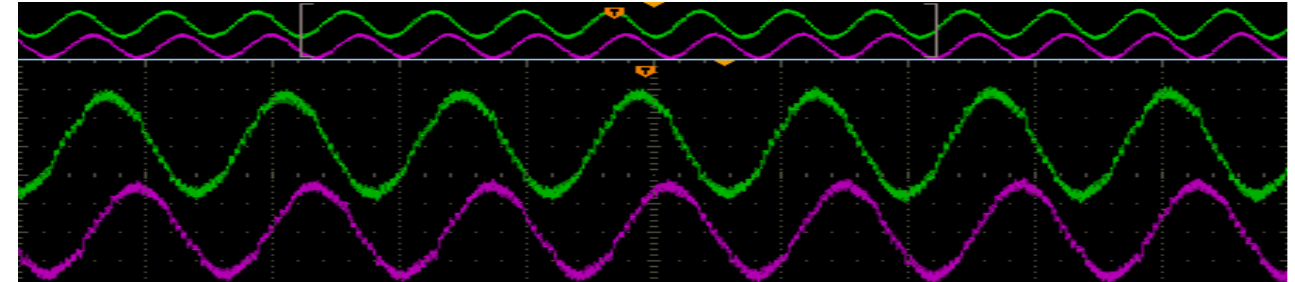
Figure 18. Schematic diagram of two-phase current of PMSM.